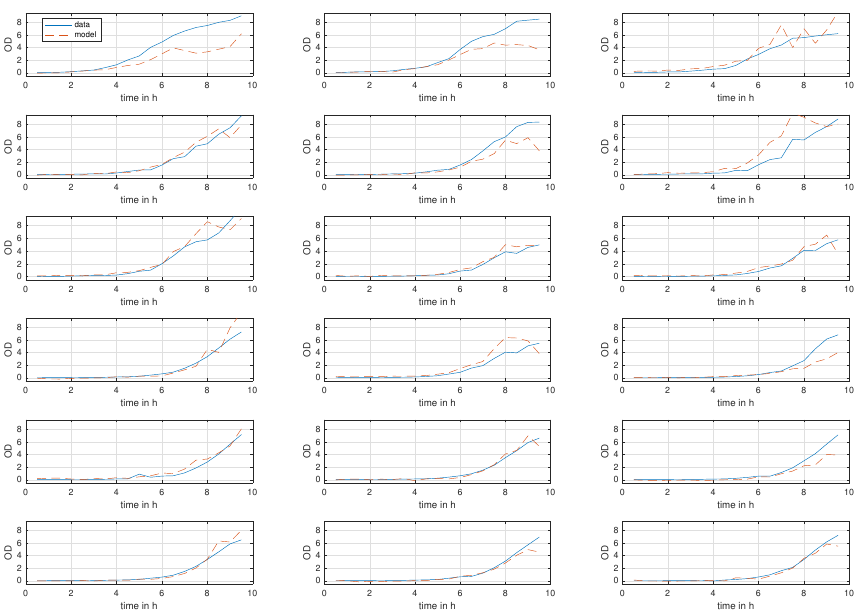
Figure 8. Observations and model predictions versus